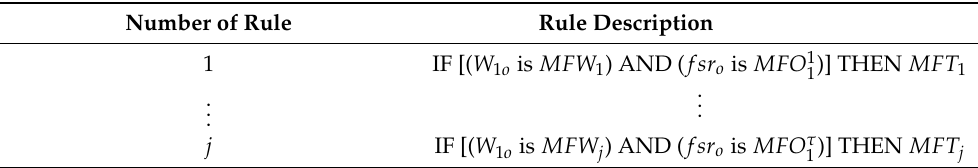
Table 3. Definition of the fuzzy rules of